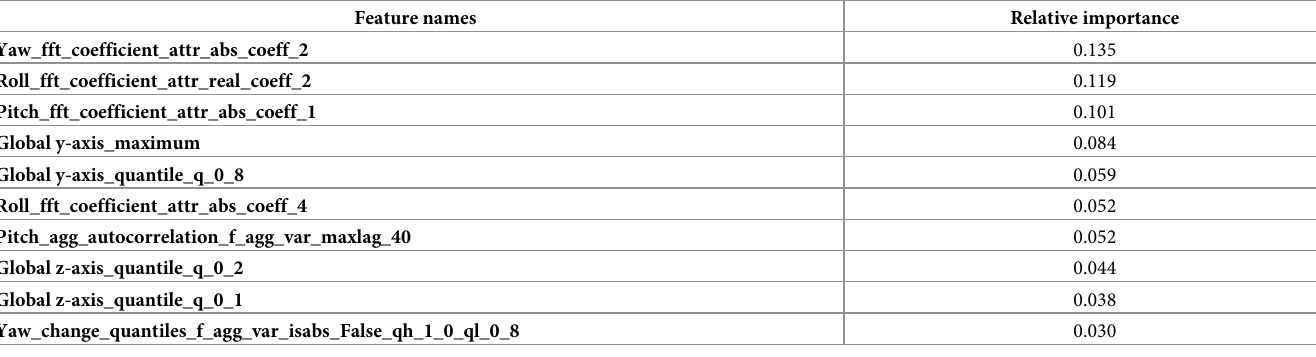
Table 1. Average relative importance of the top 10 features of the model using data of a single gait cycle.